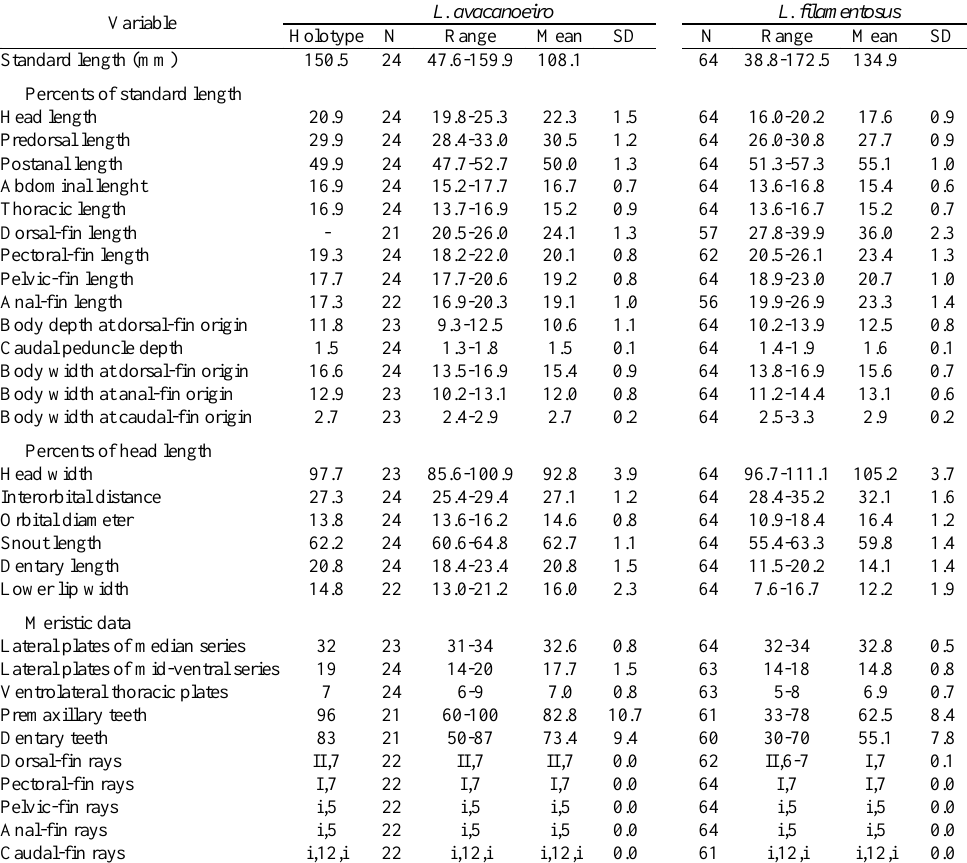
Table 1. Largest specimen 159.9 mm SL. Head and trunk totally covered with plates. Body depressed, deeper at vertical through dorsal-fin origin, gradually more depressed posteriorly to caudal-fin base and, anteriorly, to snout tip. Head ellipse shaped in dorsal view. Dorsal profile of head slightly convex. Dorsal profile of body straight from posterior tip of supraoccipital to dorsal-fin origin, posteroventrally slanted from latter point to vertical through tip of longest anal fin ray, straight from that point to caudal-fin base. Largest Table 1. Morphometric and meristic data for Lamontichthys avacanoeiro and L . filamentosus . SD = standard deviation. Range of L . avacanoeiro includes